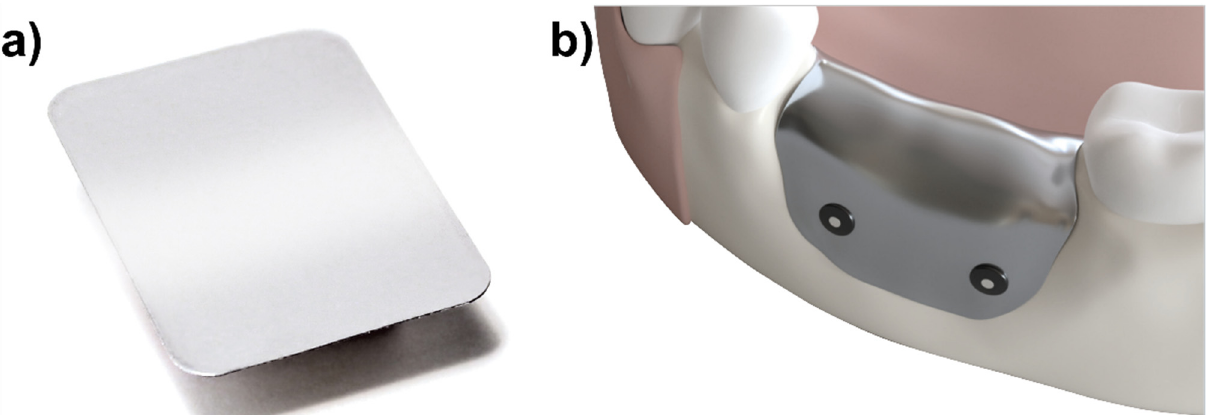
Figure 1. ( a ) Pure magnesium membrane (NOVAMag ® membrane, botiss biomaterials GmbH, Germany) used for GBR. ( b ) the magnesium membrane is positioned over the bony defect during the GBR procedure to provide a mechanical barrier between the soft and the hard tissues.